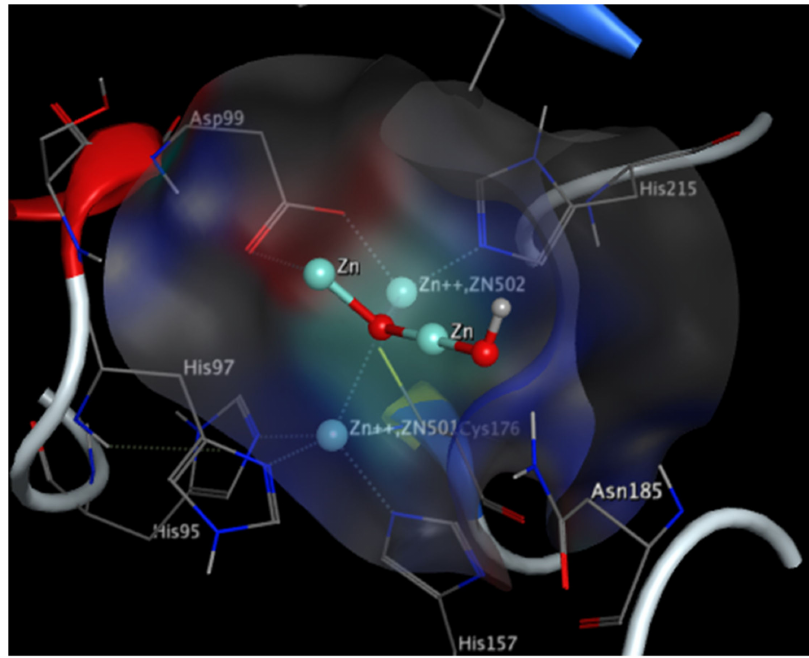
Figure 5. Three-dimensional binding mode of ZnO nanoparticles inside IMP-1 active